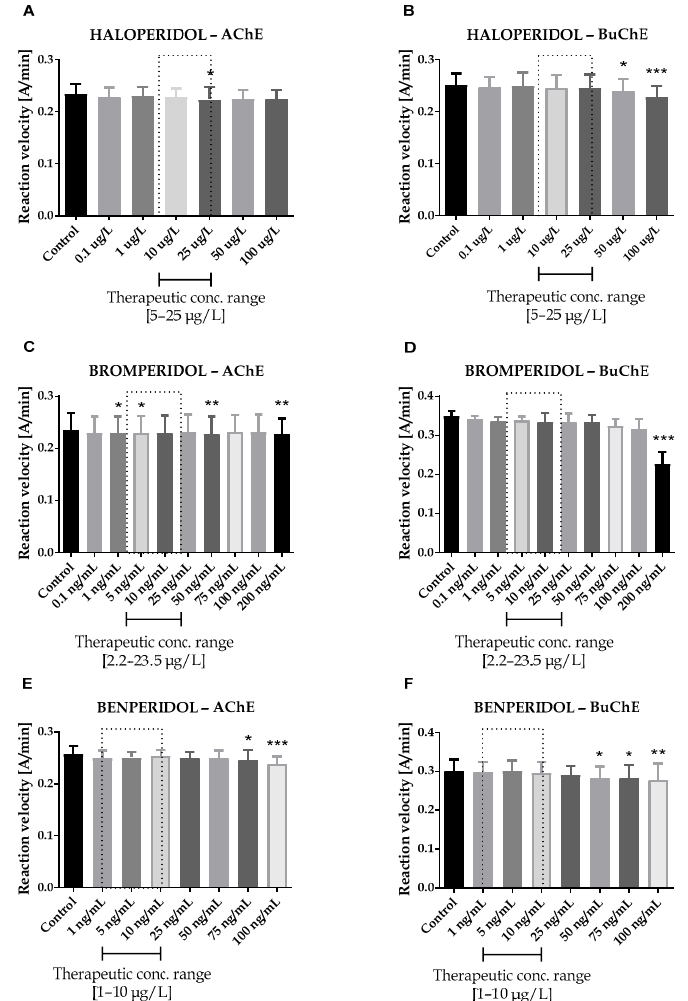
Figure 1. Effects of haloperidol ( A , B ), bromperidol ( C , D ) and benperidol ( E , F ) on AChE and BuChE in vitro activity, respectively. Each data point represents mean ± standard deviation (SD) for at least three independent experiments conducted in duplicates. * p < 0.05, ** p < 0.01, *** p < 0.001 vs. control.